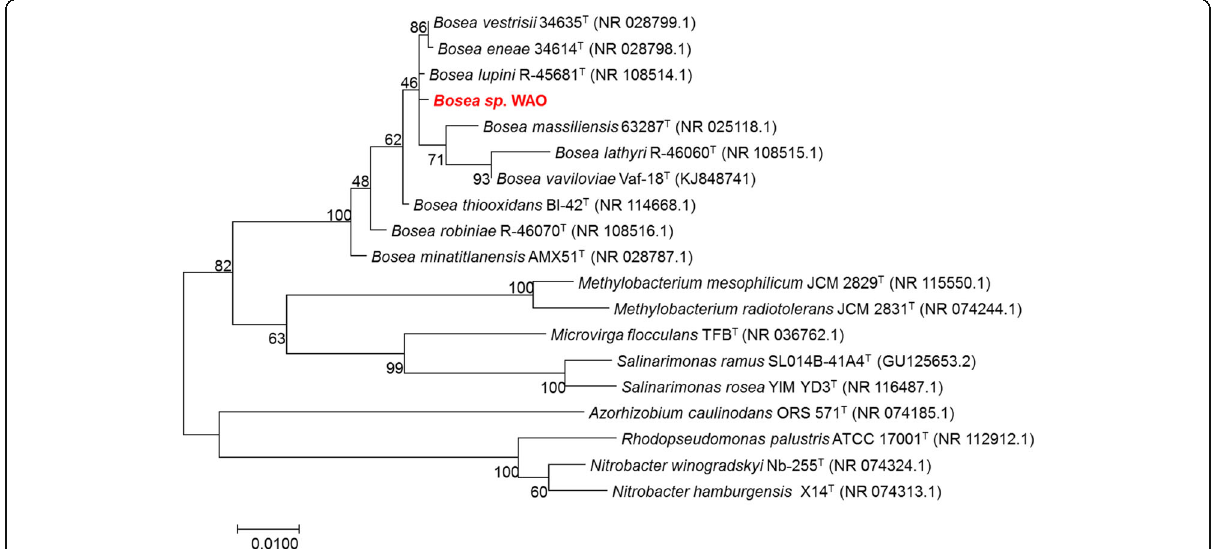
Fig. 1 Molecular Phylogenetic analysis by Maximum Likelihood method of the 16S rRNA gene. A Phylogenetic tree highlighting the position of Bosea sp. WAO relative to the other Bosea spp. based on the 16 s rRNA gene. The evolutionary history was inferred by using the Maximum Likelihood method based on the Tamura-Nei model [19]. The tree with the highest log likelihood ( − 4792.5378) is shown. The percentage of trees in which the associated taxa clustered together is shown next to the branches. Initial tree(s) for the heuristic search were obtained automatically by applying Neighbor-Join and BioNJ algorithms to a matrix of pairwise distances estimated using the Maximum Composite Likelihood (MCL) approach, and then selecting the topology with superior log likelihood value. The tree is drawn to scale, with branch lengths measured in the number of substitutions per site. The analysis involved 19 nucleotide sequences. All positions containing gaps and missing data were eliminated. There were a total of 1376 positions in the final dataset. Evolutionary analyses were conducted in MEGA7 [20]. Type strains are indicated with a superscript